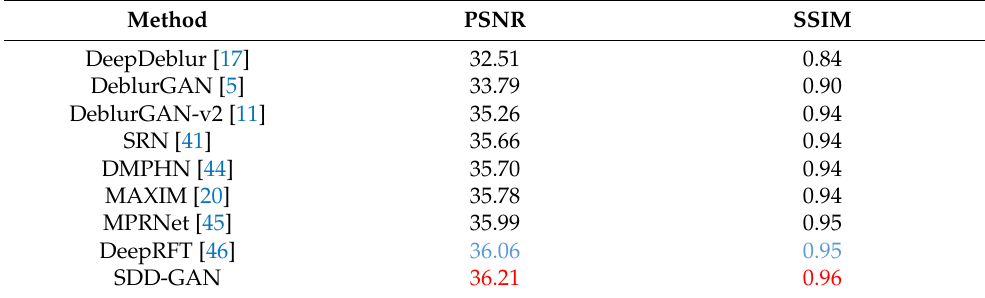
Table 3. Average PSNR and SSIM for different deblurring methods on the RealBlur-R dataset (GoPro). The highest scores are highlighted in red, and the second highest scores are highlighted in